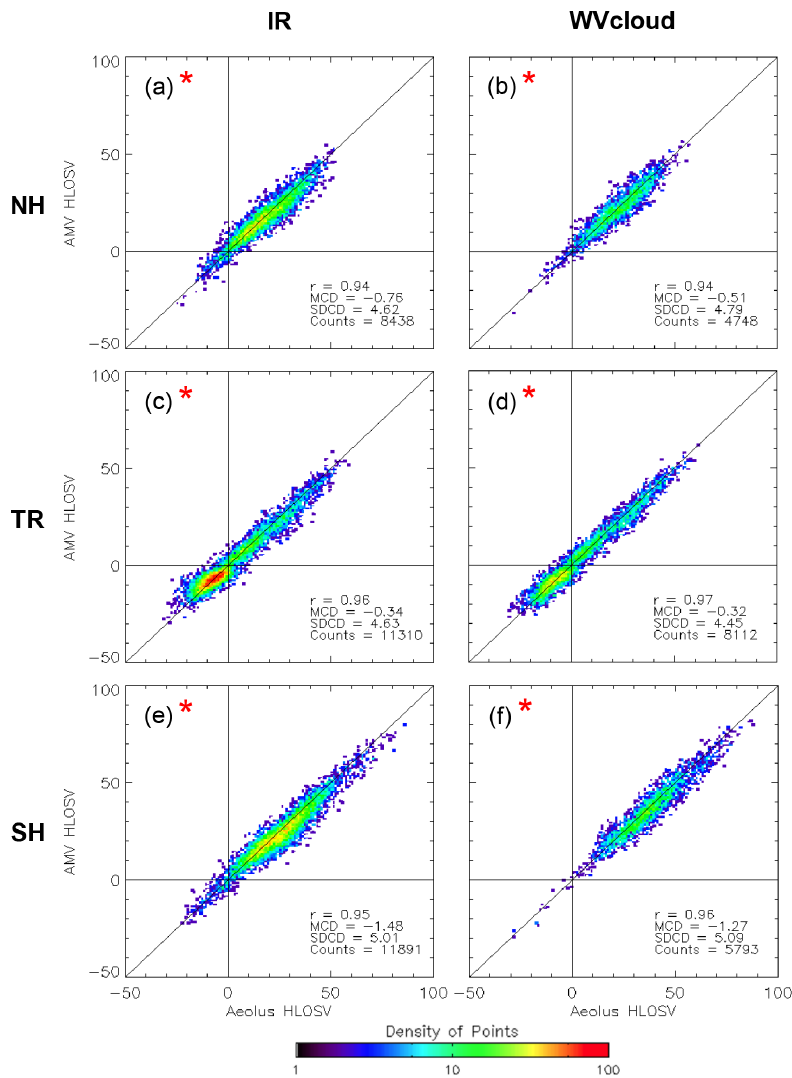
Figure 9. As in Fig. 6 but for comparisons of IR (a, c, e) and WVcloud (b, d, f) AMVs and MIE